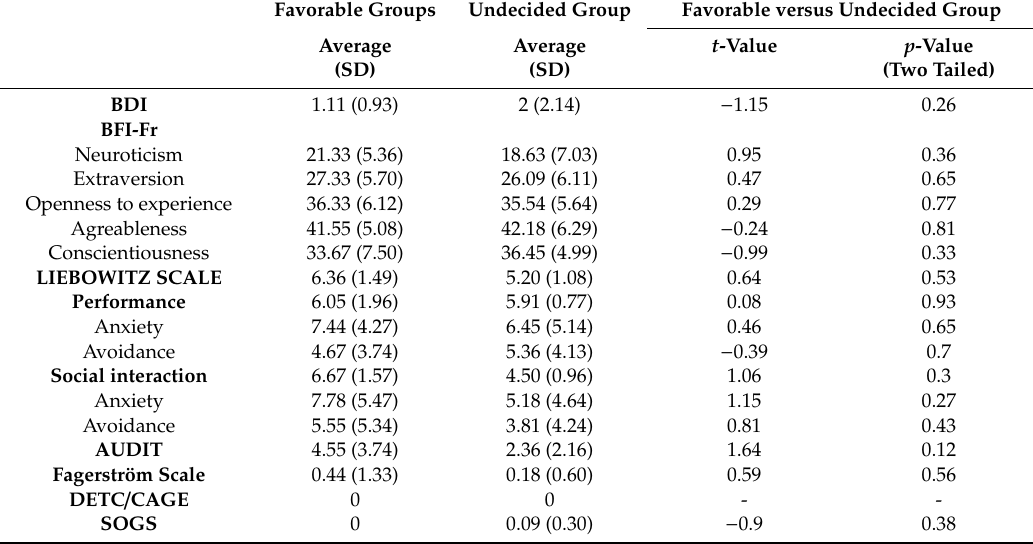
Table 1. Psychometric data. Self-report scales were used to measure pathological gambling with the South Oaks Gambling Screen (SOGS) [37], alcohol dependence with the Alcohol Use Disorder Identification Test (AUDIT) [38], the noxious use of cannabis with the Diminuer Entourage Trop Cannabis / Cut-down Annoyed Guilty Eye-opener DETC / CAGE [38], addiction to nicotine with the Fagerström test [38], the existence and intensity of depressive symptoms with the Beck Depression Inventory abbreviated version (BDI) [39], anxiety with the Liebowitz scale [40], impulsivity with the Barratt Impulsiveness Scale version 10 (BIS-10) [42], and individual di ff erences in the five personality dimensions with the Big Five Inventory-French (BFI-Fr) [41]. Favorable Groups Undecided Group Favorable versus Undecided Group Average Average t -Value p -Value (SD) (SD) (Two